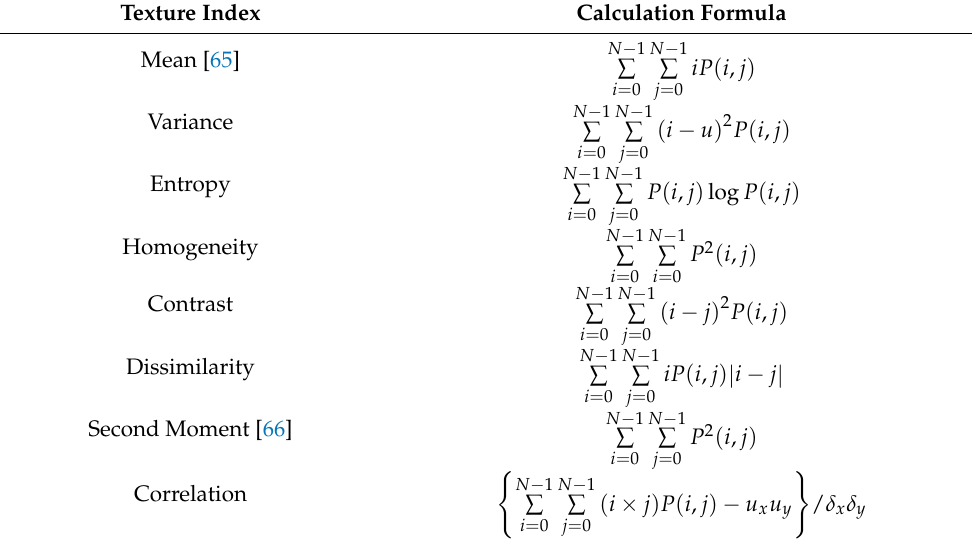
Table 2. Calculation formulae of texture